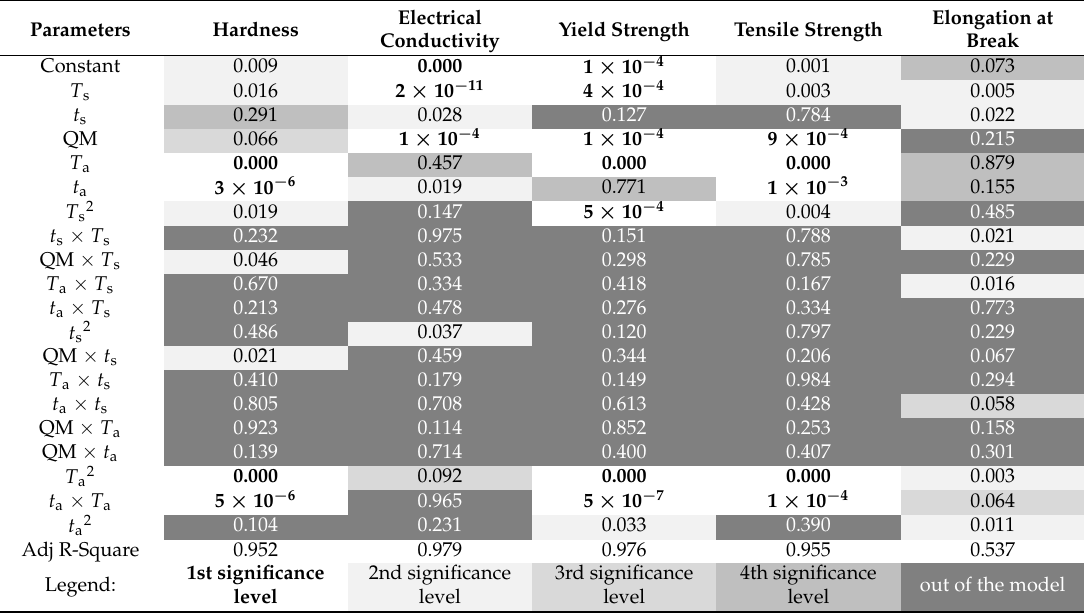
Table 4. The significance values of the